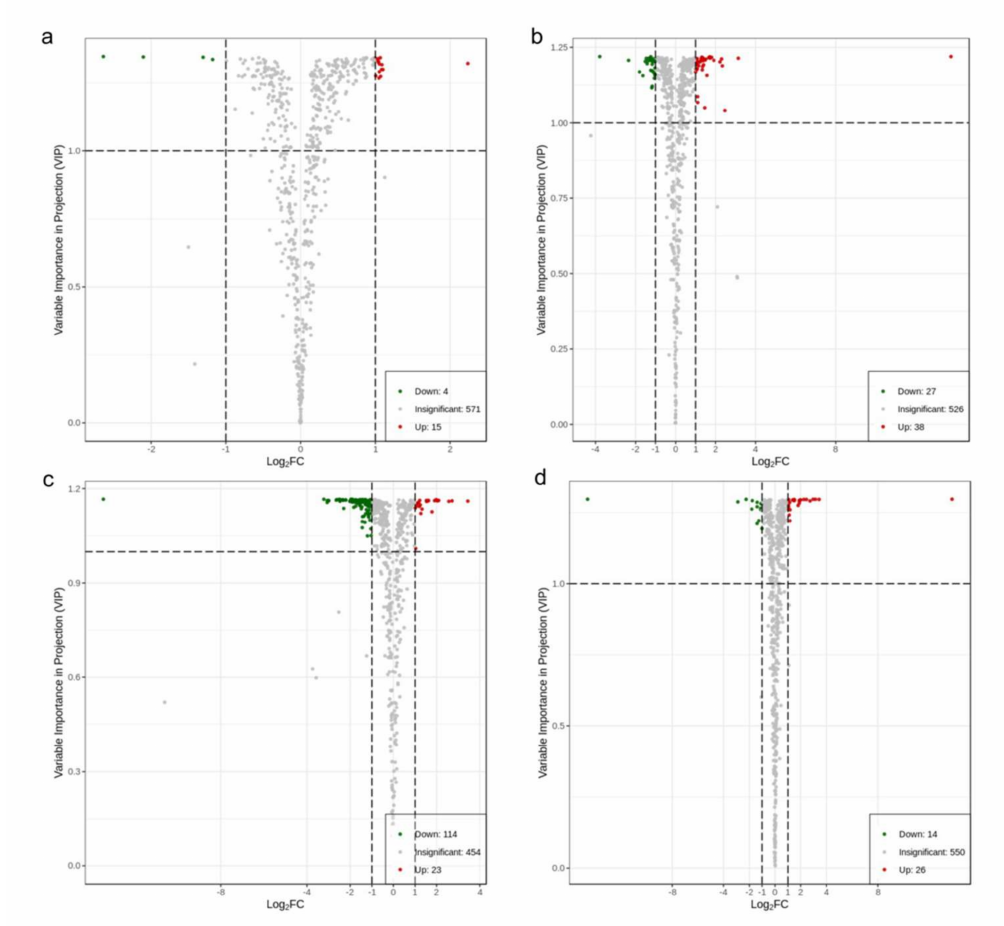
Figure 2. Metabolites with VIP values >1 and fold change ≥ 2 or 0.5, were selected as differential metabolites for each paired comparison between groups with different storage times. The X-axis was the logarithm of fold change, and the Y-axis was the VIP value. Red represents upregulated metabolites, while green represents downregulated metabolites, and grey represents insignificant metabolites. ( a ): 1 y and 3 y; ( b ): 3 y and 7 y; ( c ): 7 y and 14 y; ( d ): 14 y and 25